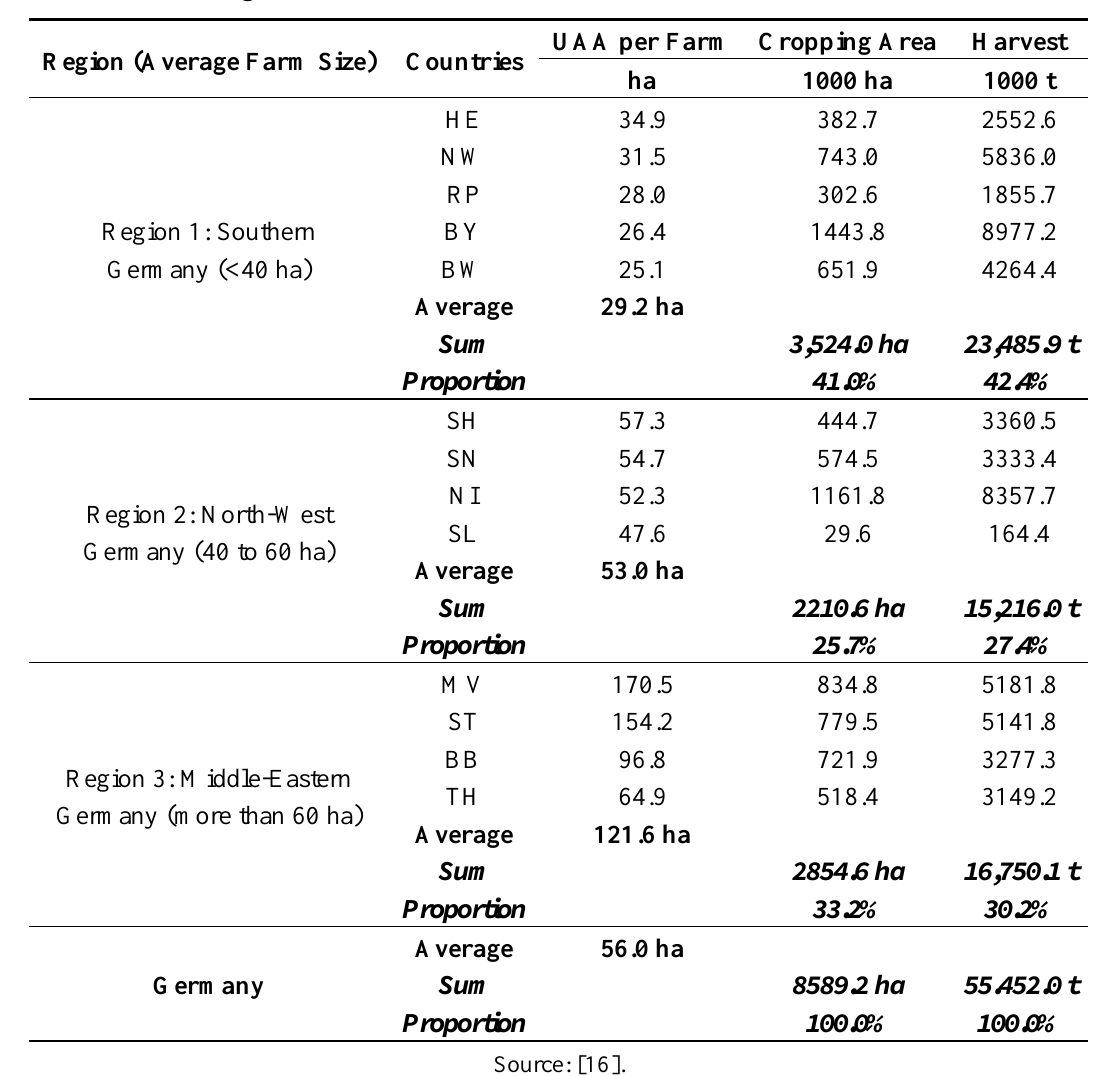
Table 2. Classification of threshing regions in Germany on the basis of the average farm size in ha utilized agricultural area (UAA).